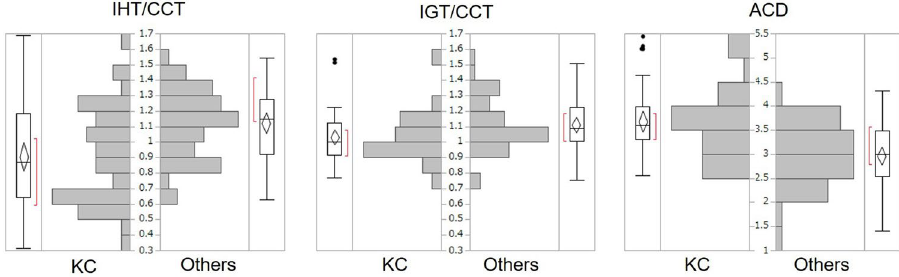
Figure 2. Distributions of corneal ectasia indicators (IHT/CCT, IGT/CCT, and ACD) in the KC and Others groups. Both the inferior host cornea and graft were thinner in the KC group, but the tendency was more obvious in the host cornea. The ACD tend to be larger in the KC group, suggesting more severe corneal